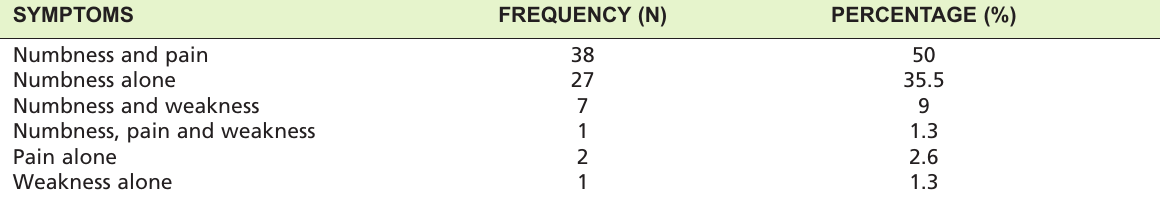
Frequency of the symptoms Table III: